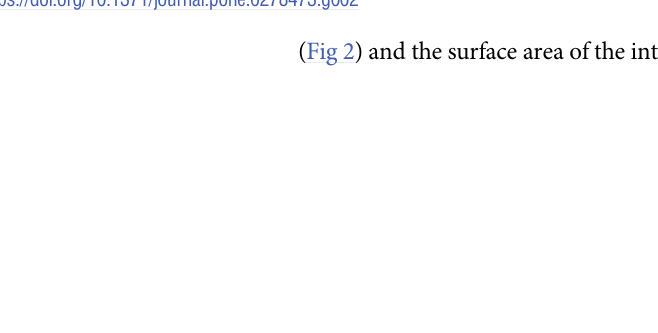
(Fig 2) and the surface area of the intercellular space (S